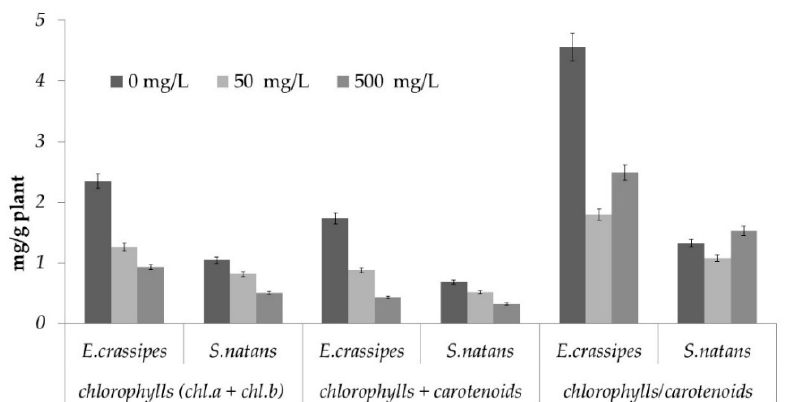
Figure 8. Photosynthetic pigment determination for plants in 0, 50, and 500 mg/L dye solution.